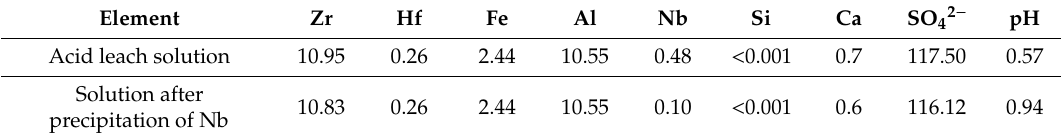
Table 1. Chemical composition of experimental solutions, g /